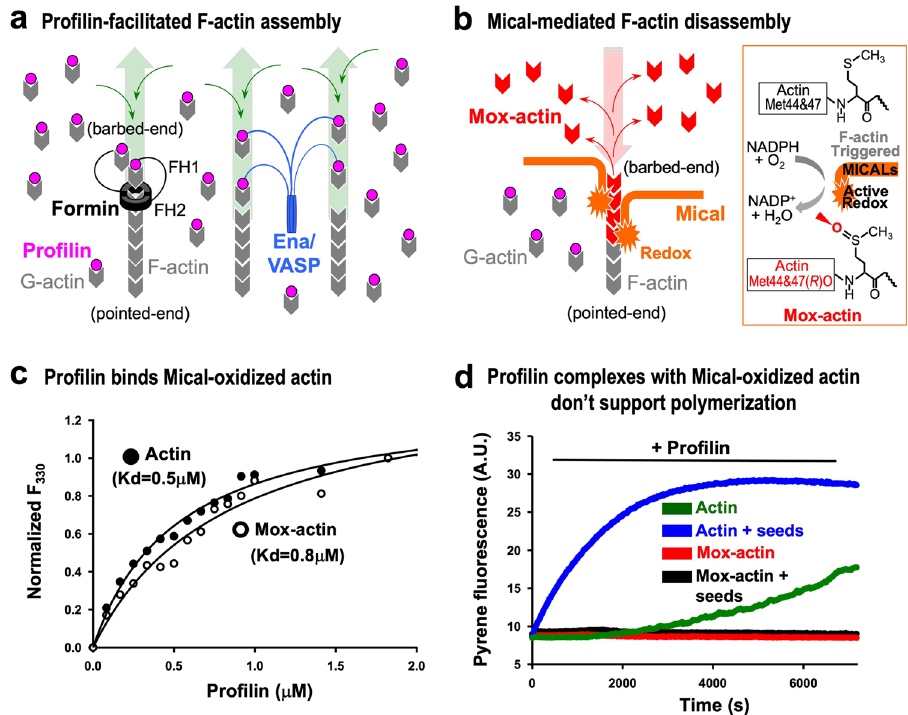
Fig. 1 Mical-oxidized actin binds and inhibits pro fi lin-assisted actin polymerization. a Pro fi lin facilitates polymerization by fueling F-actin assembly by elongation-promoting factors (formins, Ena/VASP). In particular, most cellular monomeric/G-actin is complexed with G-actin binding proteins such as pro fi lin (pink). These pro fi lin – actin complexes associate with elongation-promoting factors such as formins (black) and Ena/VASP (blue) to drive monomers ’ incorporation (thin green arrows) leading to F-actin elongation (thick green arrows) in a tightly controlled manner. Based on current models, formins trigger actin nucleation by stabilizing transient actin dimers. Formins are shown here as dimers, such that each FH1 domain binds pro fi lin – actin and delivers it to FH2 domains, which are bound to actin ’ s barbed-end. For simplicity, the cell membrane is neither illustrated, nor formins ’ or Ena/VASP ’ s association with it. b Mical post-translationally and speci fi cally oxidizes actin to induce F-actin disassembly. In particular, based on current models, Mical with its Redox region (orange, left model and inset) directly associates with F-actin. F-actin triggers Mical ’ s Redox enzymatic activity (inset) — such that with its co-enzyme NADPH, Mical stereospeci fi cally (in the R -isomer conformation) oxidizes Met44 and Met47 residues (inset) in the D-loop at actin ’ s pointed end. This generates Mical-oxidized actin (Mox-actin) (red, model and inset). Since this oxidation occurs on residues along the interface of actin fi lament subunits, it weakens the interactions between individual fi lament subunits and promotes F-actin disassembly (thin red arrows) and shortening (thick red arrow). c Pro fi lin binds to Mical-oxidized actin to a similar extent as to unoxidized actin. Binding of human pro fi lin-1 to actin was measured by changes in tryptophan fl uorescence of actin. Unoxidized actin (closed circles). Mox-actin (open circles). n = 2 (two different preps of both actins) with each data point an average of two independent experiments. Dissociation constants (Kd) for unoxidized and Mox-actin under G-buffer conditions are estimated as 0.5 and 0.8 µ M, respectively. [Actin] = 0.15 µ M; excitation wavelength (295 nm), emission (330 nm). F 330 = normalized fl uorescence at 330 nm. d Pro fi lin complexes with unoxidized actin (blue, green traces), but not with Mical-oxidized actin (red, black traces), polymerize (with or without F-actin seeds). [Actin] = 3 µ M; [pro fi lin] = 9 µ M; [F-actin-phalloidin seeds] = 0.25 µ M (stabilized with phalloidin (Ph) at 1:50 Ph:actin molar ratio). A.U. arbitrary units. n = 2 separate experiments with similar results. Source data for Fig. 1 are provided as a Source Data fi